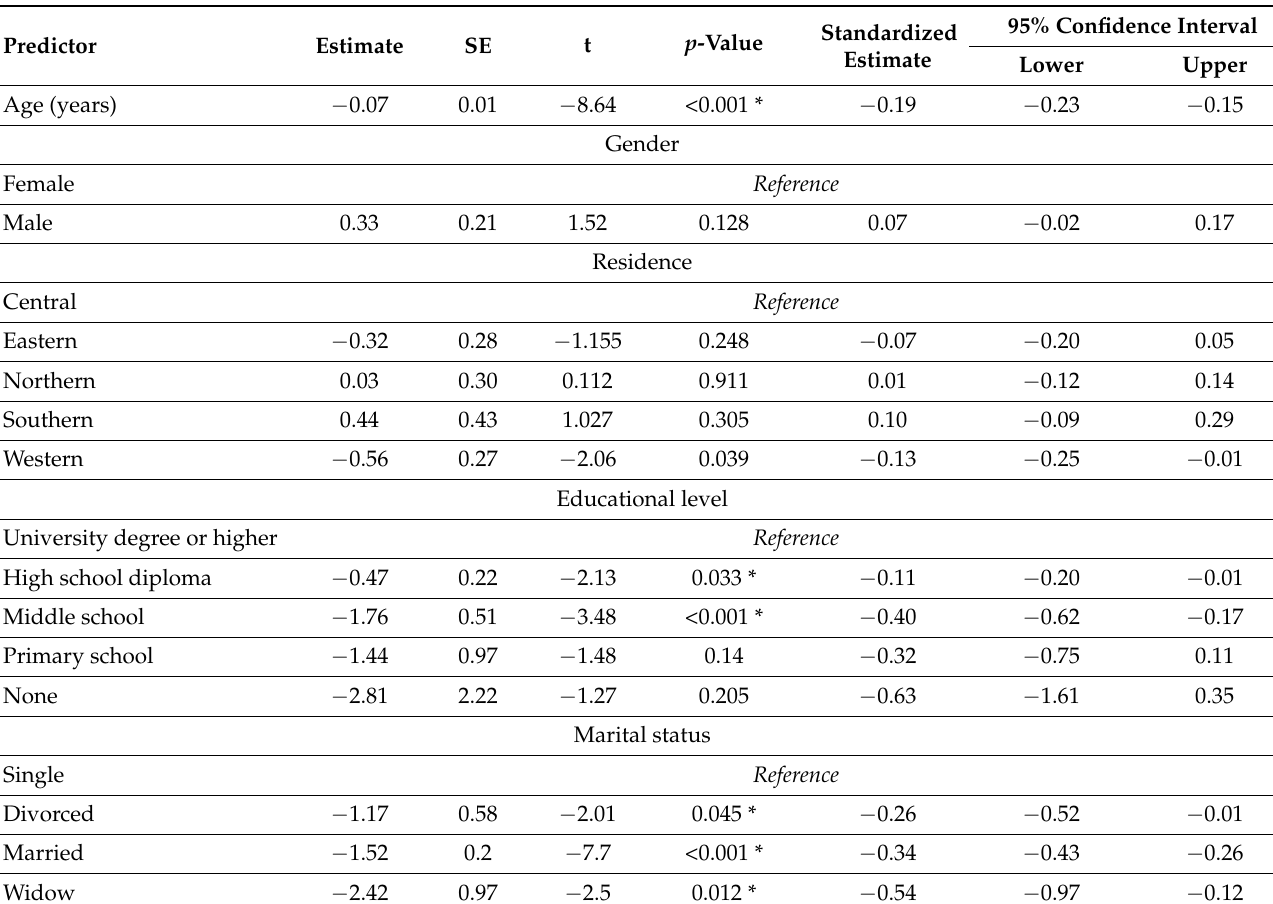
Table 3. Univariate linear regression of different predictors of the awareness and knowledge